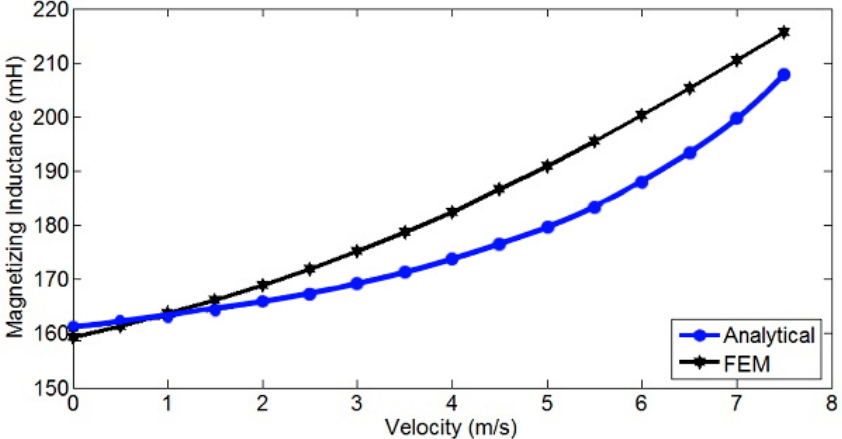
Table 2. Equivalent circuit parameters of the LIM.